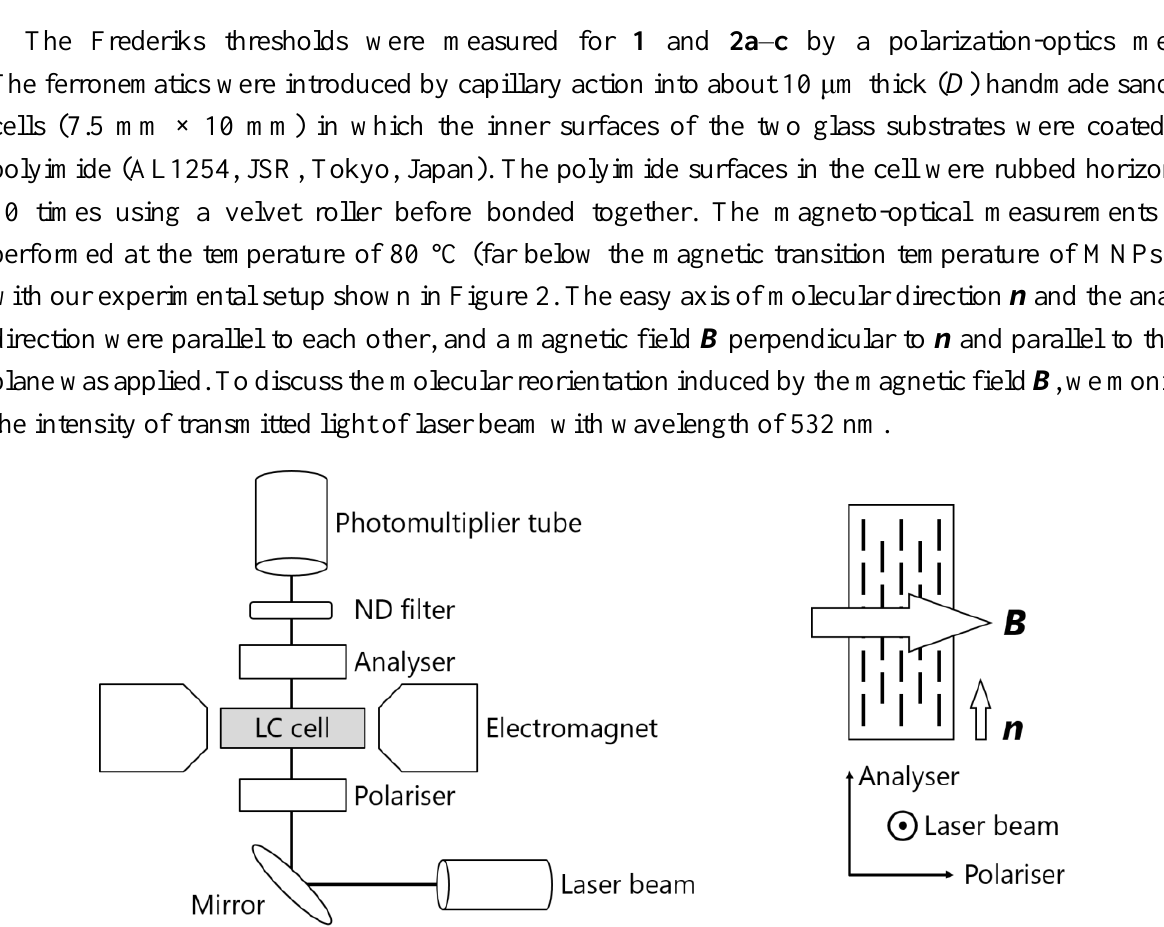
Figure 1. Chemical structure of one of the enantiomers of 1 (2 S , 5 S ) and phase transition temperatures (°C) of racemic 1 . The temperatures were determined by differential scanning calorimetry (DSC) upon heating. Standard notation gives the transition temperatures between the crystalline (Cr), nematic (N) and isotropic (Iso) phases.